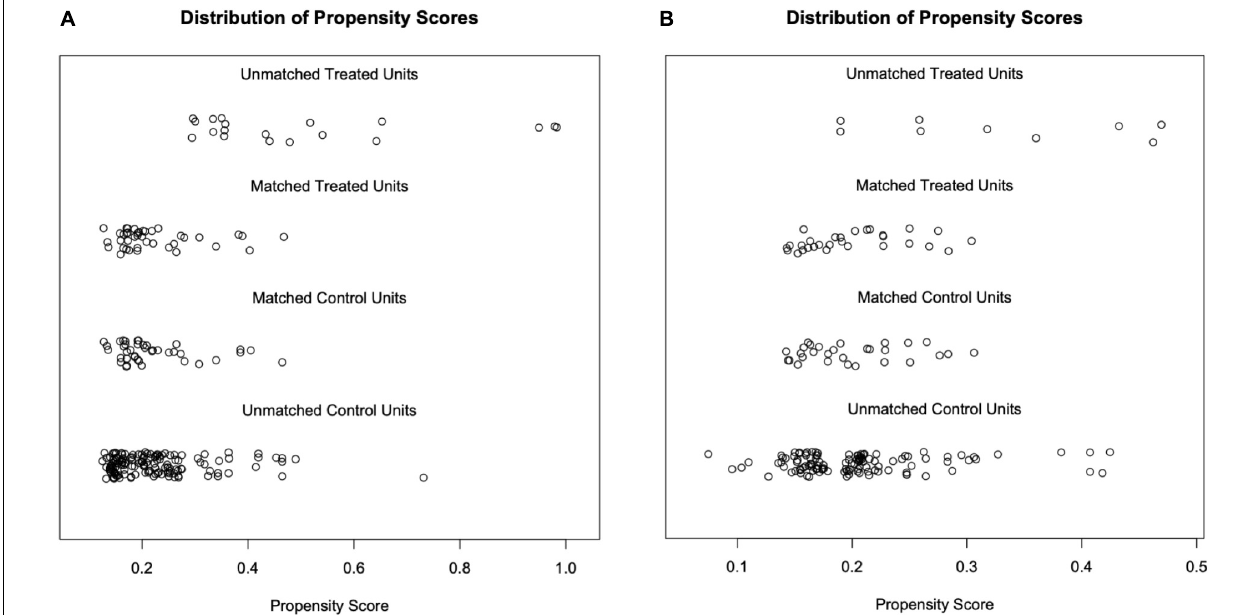
FIGURE 2 | Distribution of propensity scores. Each circle represents an individual, and its corresponding value on the x -axis represents its propensity score. (A) After matching, the propensity scores of the RASI group were mainly distributed from 0.10 to 0.50, as well as the HCQ + RASI group. (B) After matching, the propensity scores of both groups, the RASI + P ± IM group and HCQ + RASI + P ± IM group, were mainly distributed from 0.15 to 0.35.